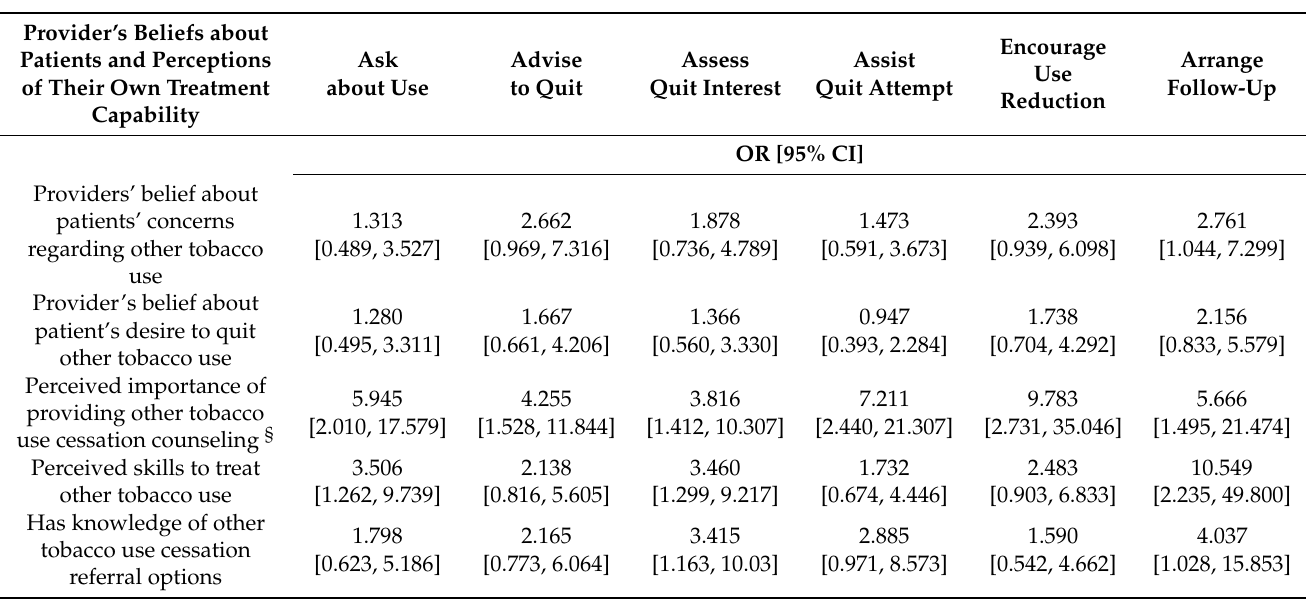
Table 2. Providers’ Non-Cigarette Tobacco Use Intervention Practices with Patients Relative to Their Beliefs about Patients’ Other Tobacco Use and Their Perceptions of Their Own Treatment Capability ( n = 86 healthcare